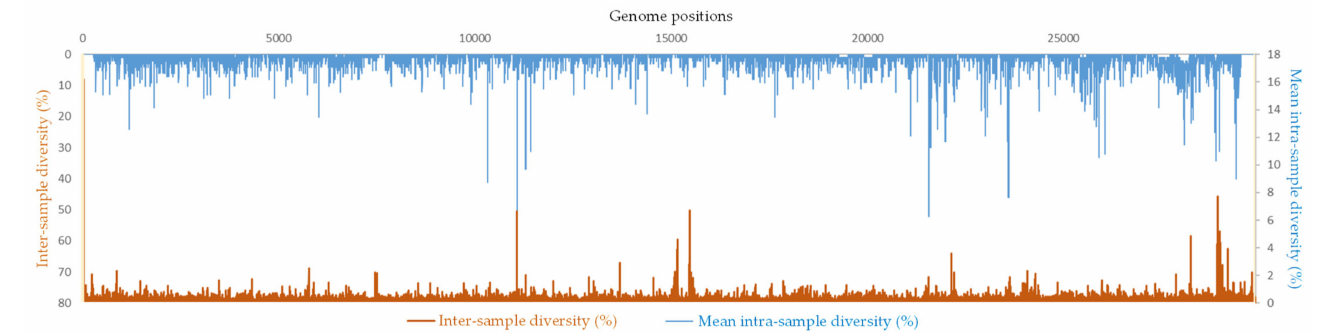
Figure 3. Correlation between the intra-sample genetic diversity in the present study and the inter- patient diversity at the global